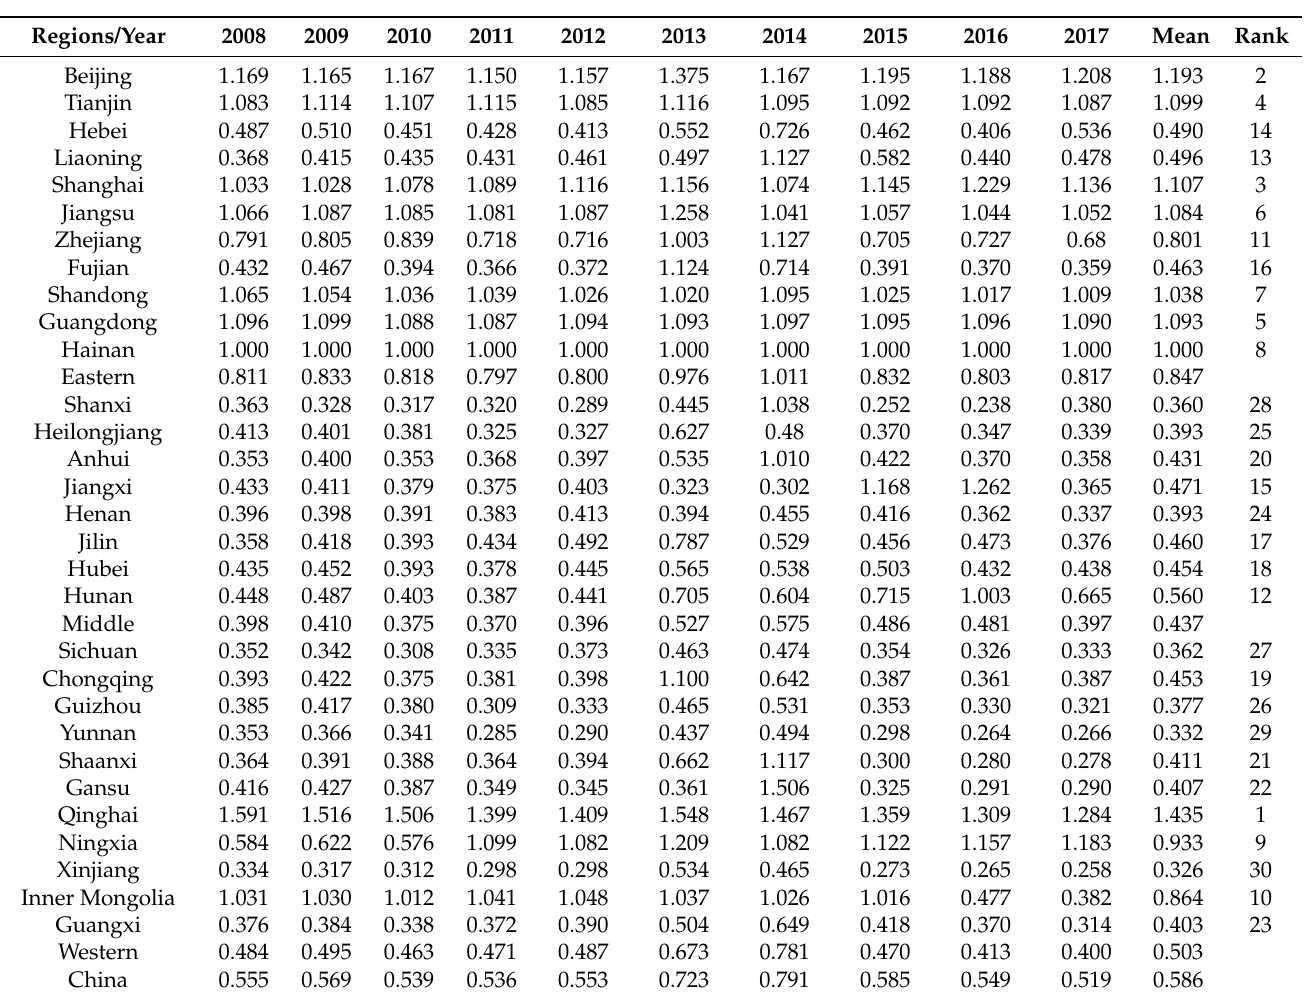
Table 2. Green economic efficiency values in provinces of China from 2008 to